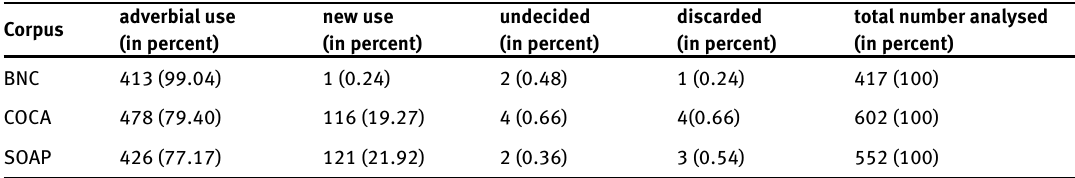
Table 4. Distribution of uses of already across corpora Corpus